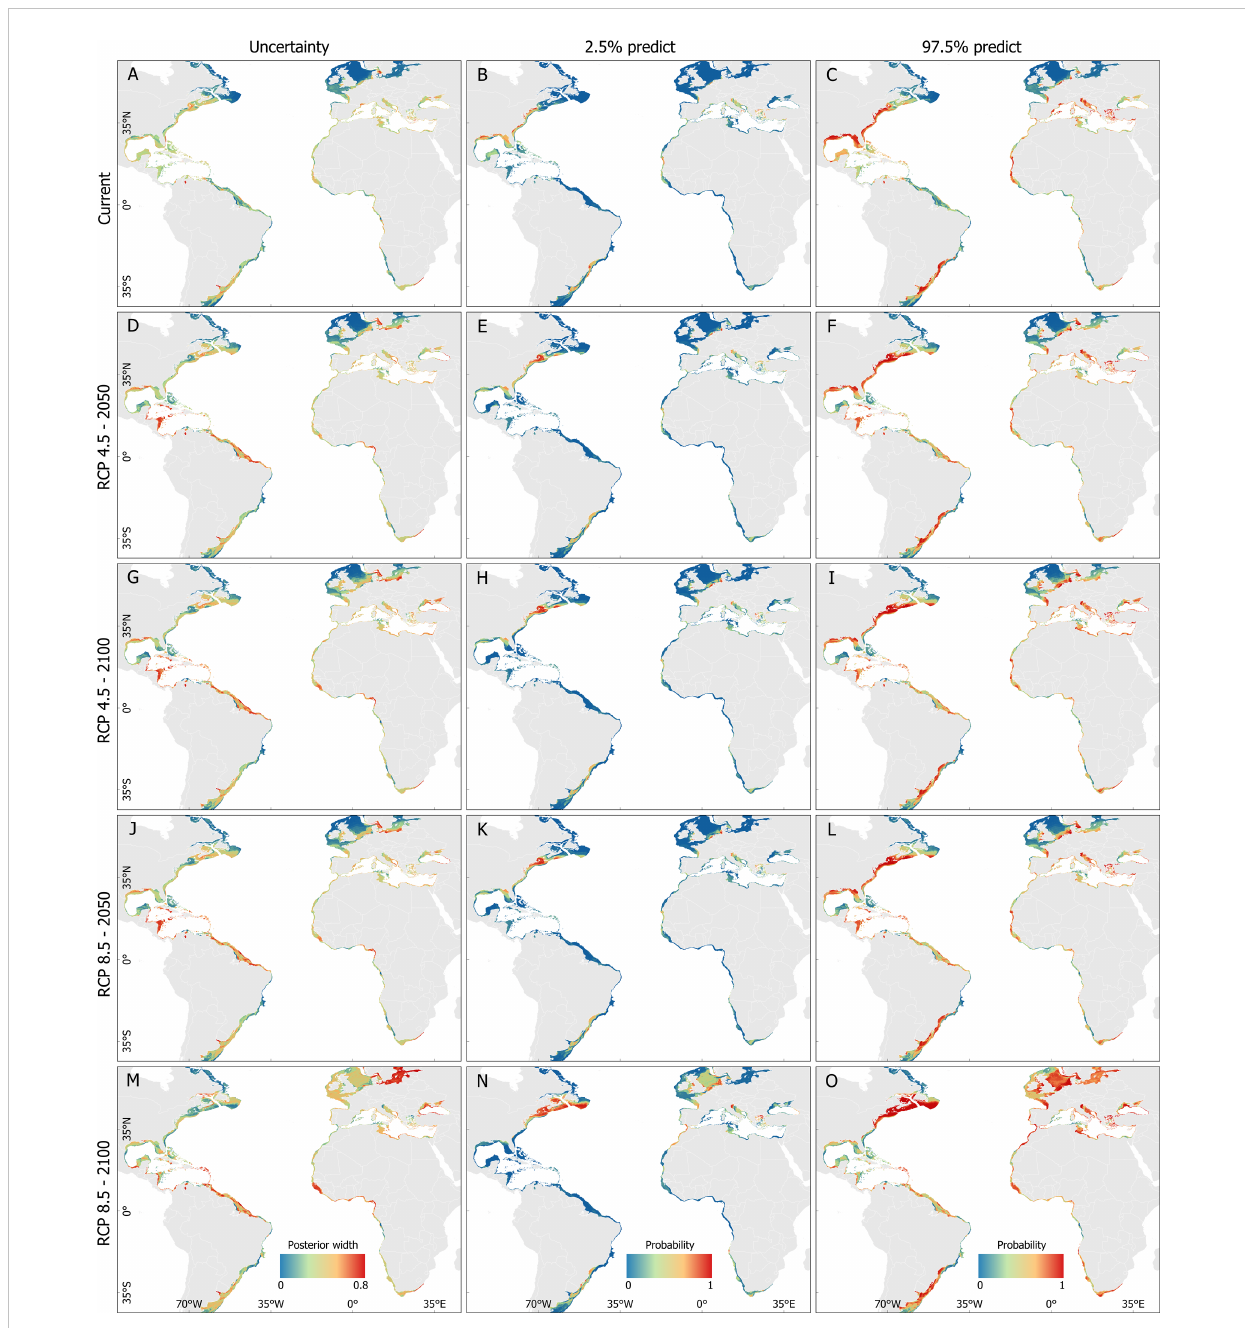
FIGURE 6 Prediction of the Atlantic blue crab Callinectes sapidus Rathbun, 1896 distribution between 1832 and 2022 (A – C) and under the in fl uence of RCP 4.5 2050 (D – F) , RCP 4.5 2100 (G – I) , RCP 8.5 2050 (J – L) , and RCP 8.5 2100 (M – O) . The uncertainty areas are shown in the left column, the 2.5% quantile in the center column, and the 97.5% quantile in the right